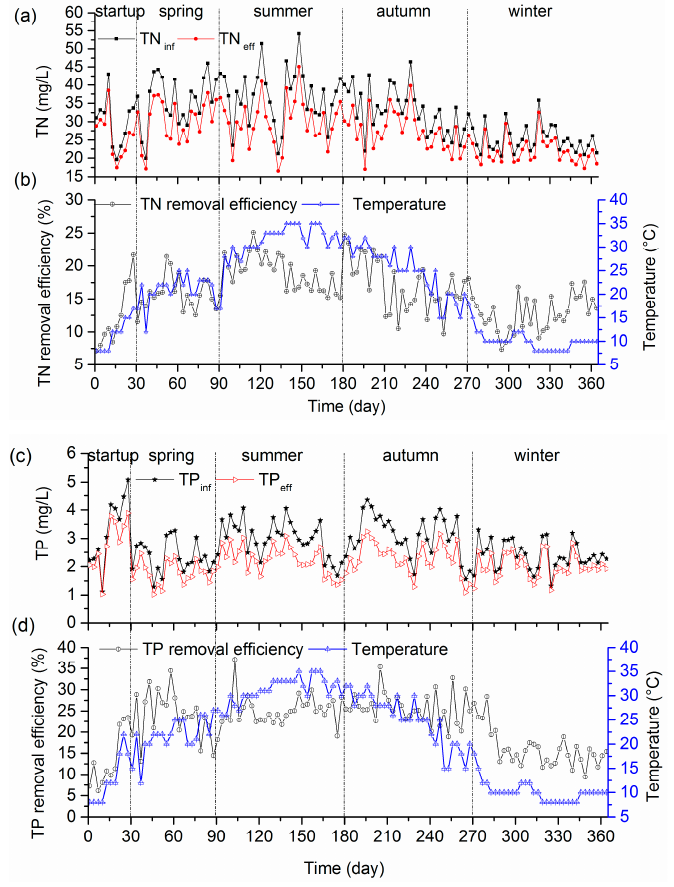
Figure 6. Total nitrogen (TN) ( a , b ) and total phosphorus (TP) ( c , d ) concentration in influent, effluent and the removal efficiency throughout the operation period.